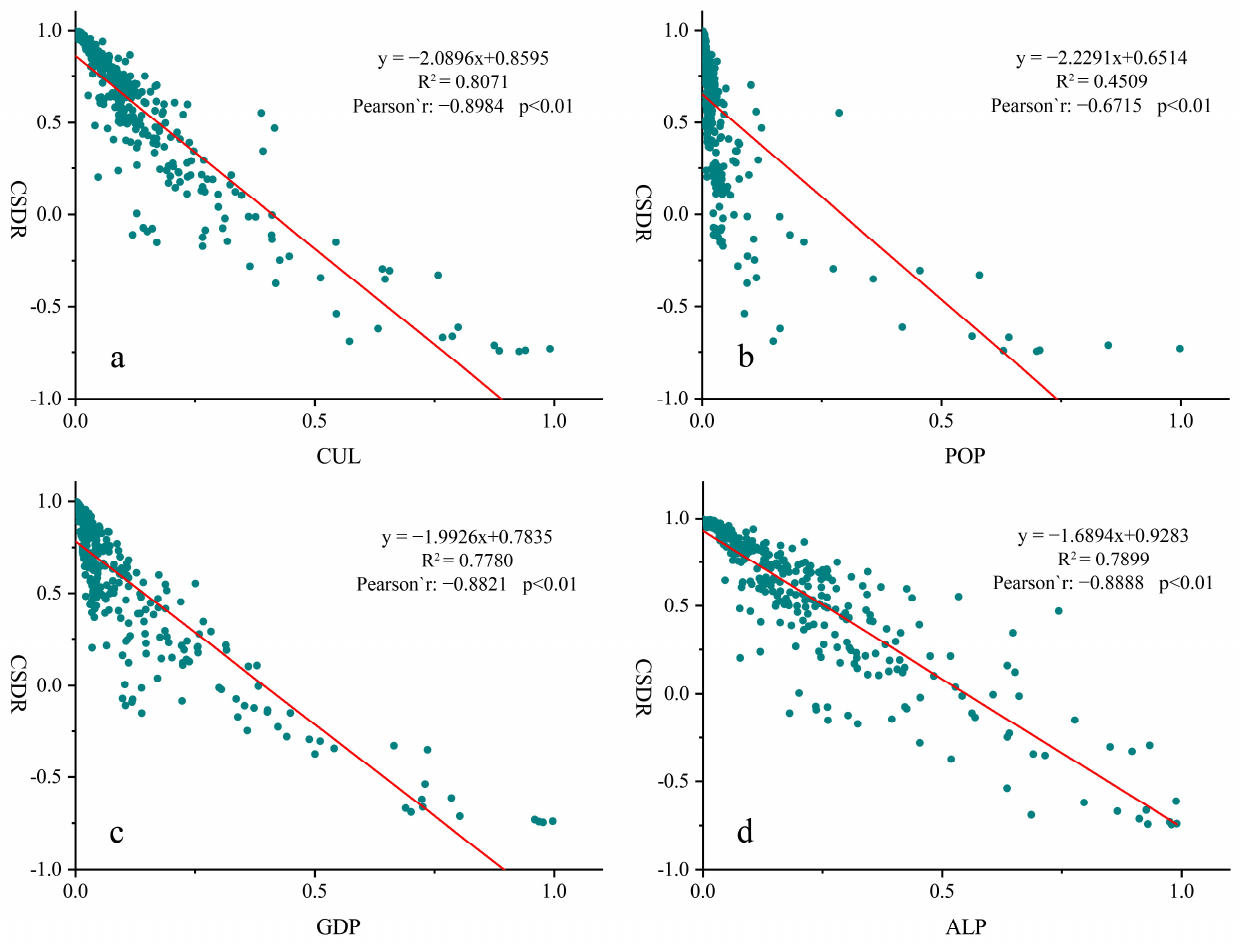
Figure 6. Linear regression model showing the CSDR dependency of integrated urbanization indicator CUL and each urbanization indicators in 2020.